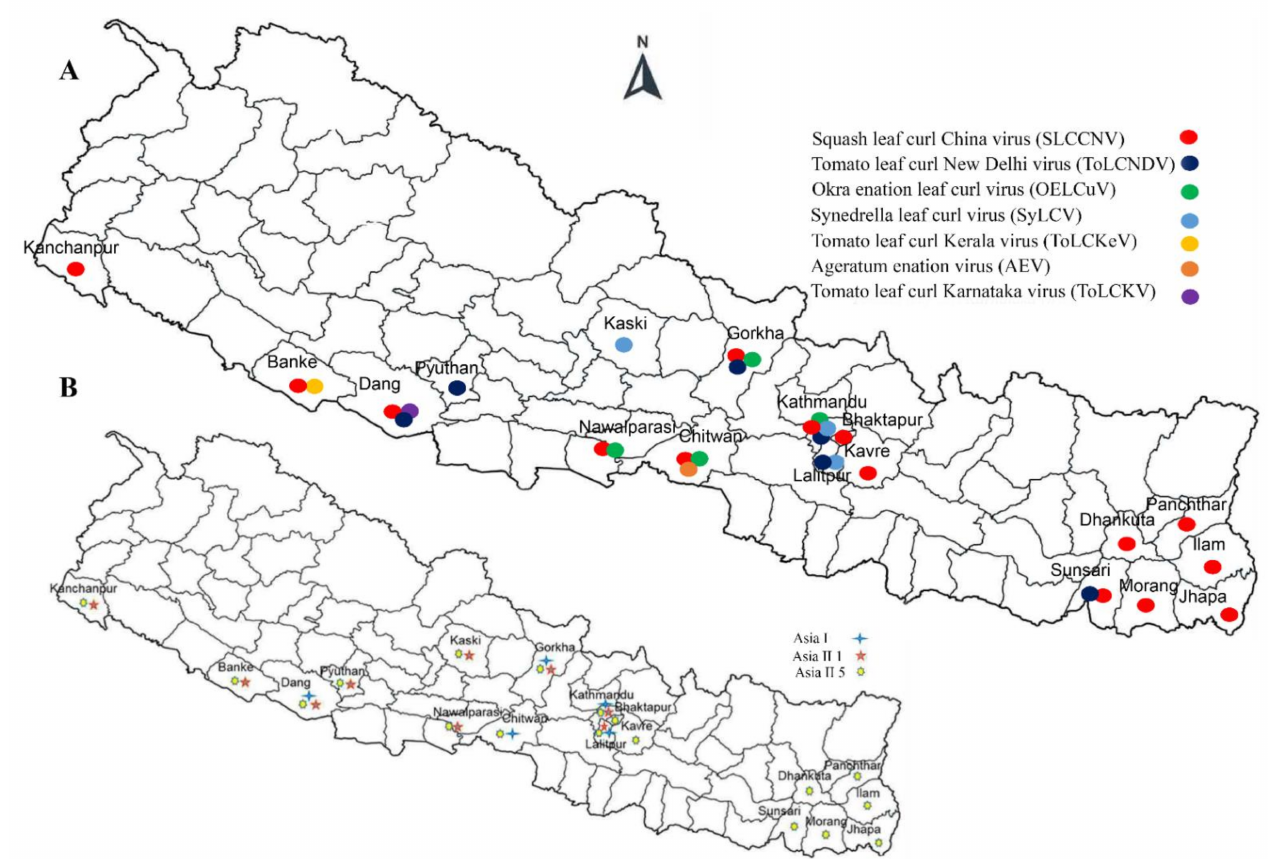
Figure 1. Map of Nepal showing the distribution of the begomoviruses ( A ) and distribution of Bemisia tabaci cryptic species ( B ) [31] in the country. The seven different colors represent the detected begomoviruses species from the different cryptic species of B. tabaci ( A ) whereas different symbols represent B. tabaci cryptic species ( B